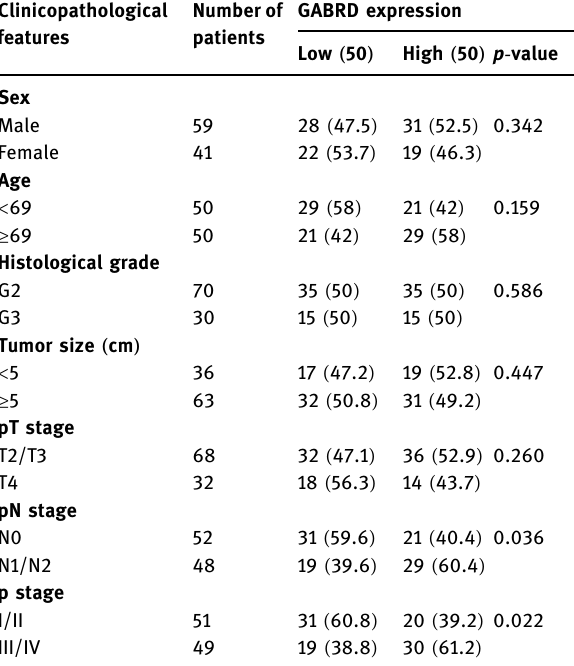
Abbreviations: GABRD, gamma - aminobutyric acid type A receptor subunit